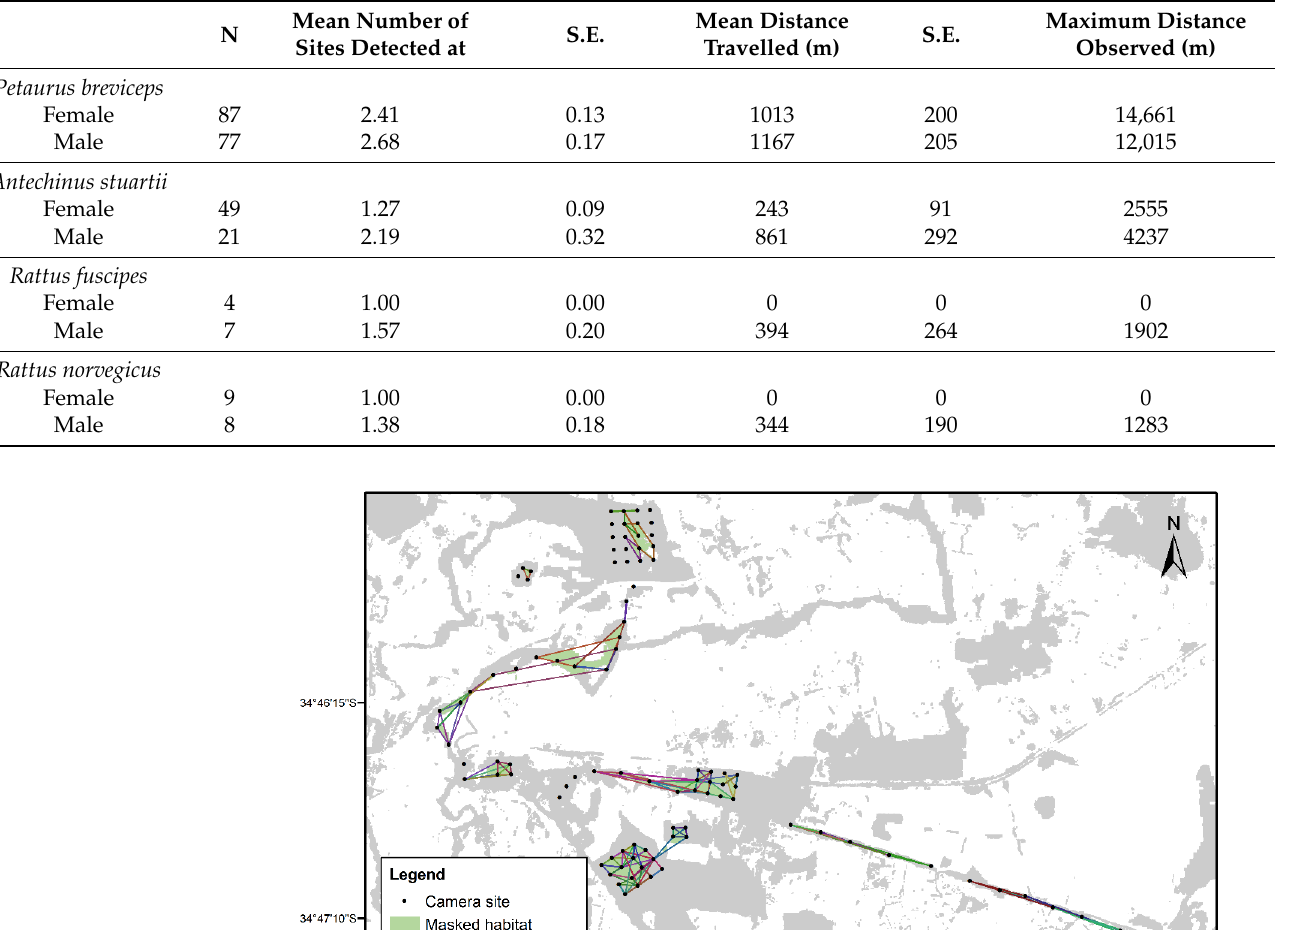
Table 3. Movement distances observed on selfie traps for individual small mammals (of known sex) over 28-trap night periods, between August and November 2019. Included are the mean and maximum of direct straight-line distances moved by an individual small mammal.